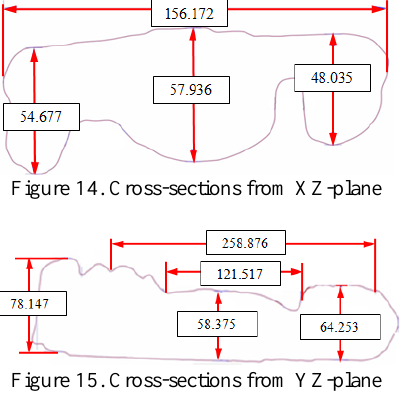
Figure 15. Cross-sections from YZ-plane